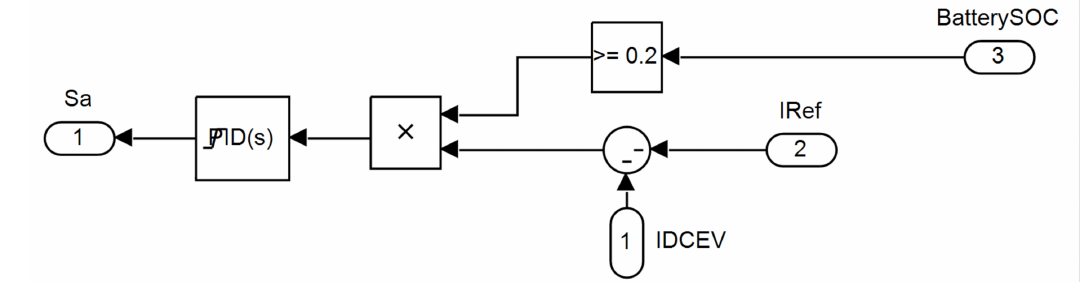
Figure 11. Control algorithm when discharging the battery bank.